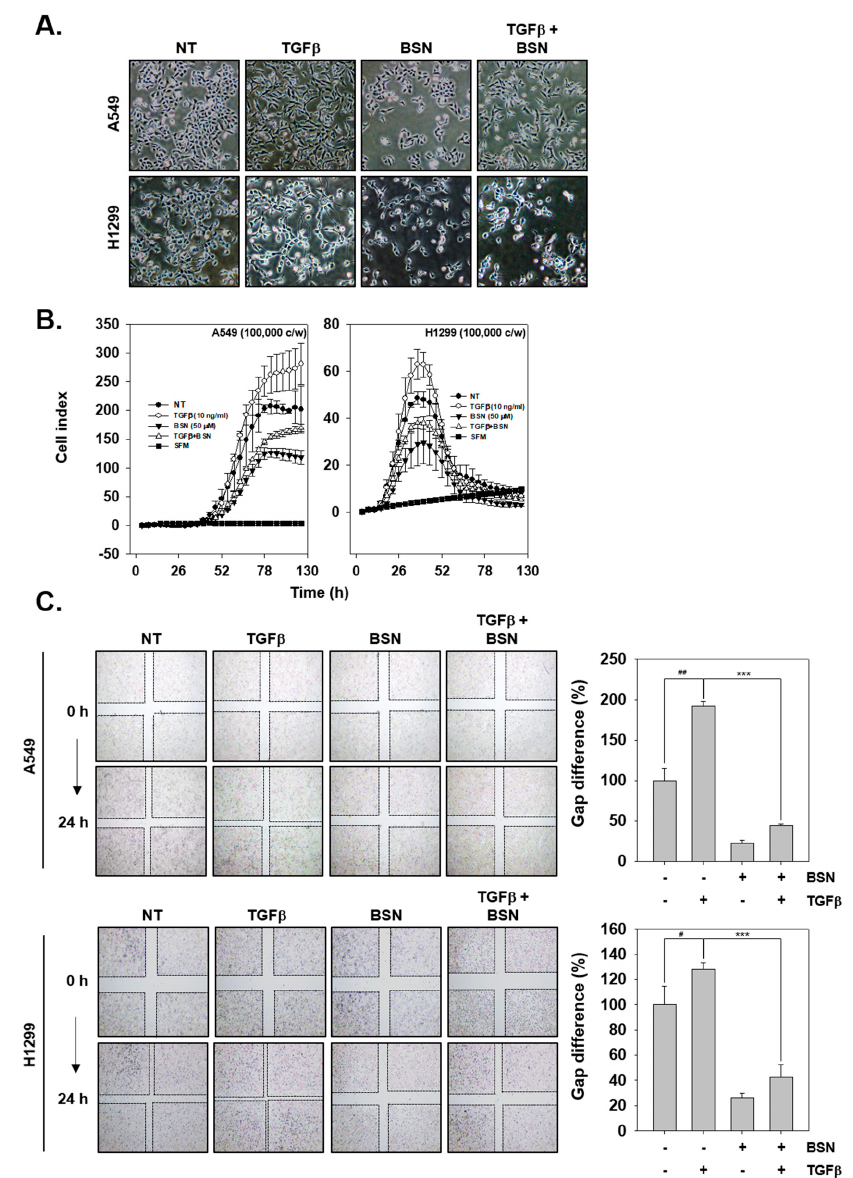
Figure 4. BSN treatment also modulates the oncogenic characteristics of TGF- β treated cells. ( A ) The cells were treated as described in Figure 2A and morphological changes were observed by Nikon ECLIPSE Ts2. ( B ) Invasion assay was performed as indicated in Figure 2. ( C ) Migration assay was carried out. Cells were treated with TGF- β (10 ng/mL, − /+), BSN (50 μ M, +/ − ), or the combination condition (+/+) for 24 h. Data represent means ± SD; ## p < 0.01 vs. non-treated (NT) cells, # p < 0.05 vs. non-treated (NT) cells, and *** p < 0.01 vs. TGF- β treated cells.